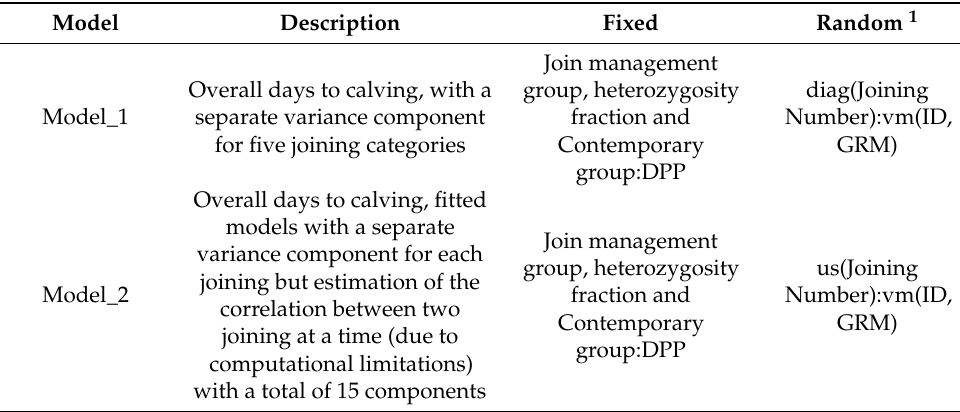
Table 2. Description of models run for days to